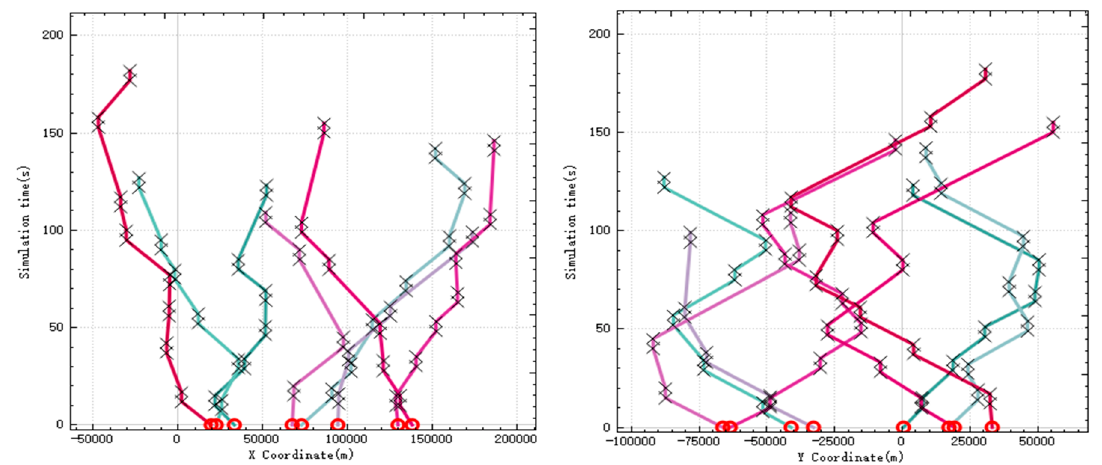
Figure 2. UAV position over time.